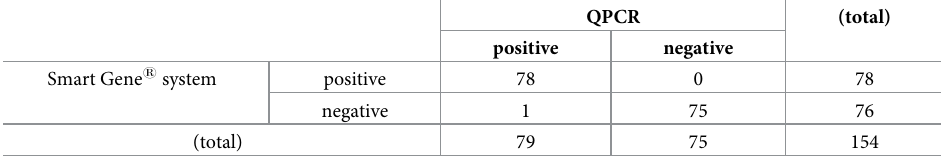
Table 1. Sensitivity and specificity of the Smart Gene 1 system for detection of M . pneumoniae .